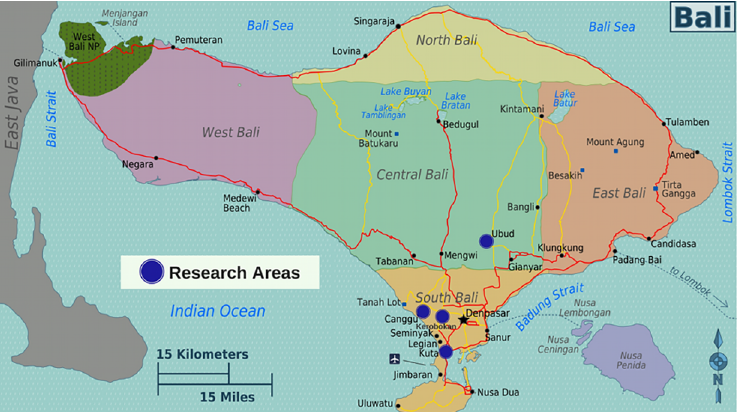
Fig 2. Map of Bali and research areas (Authors: Burmesedays, Peter Fitzgerald, Marco Adda [CC BY-SA 4.0–3.0– 2.5–2.0–1.0]).